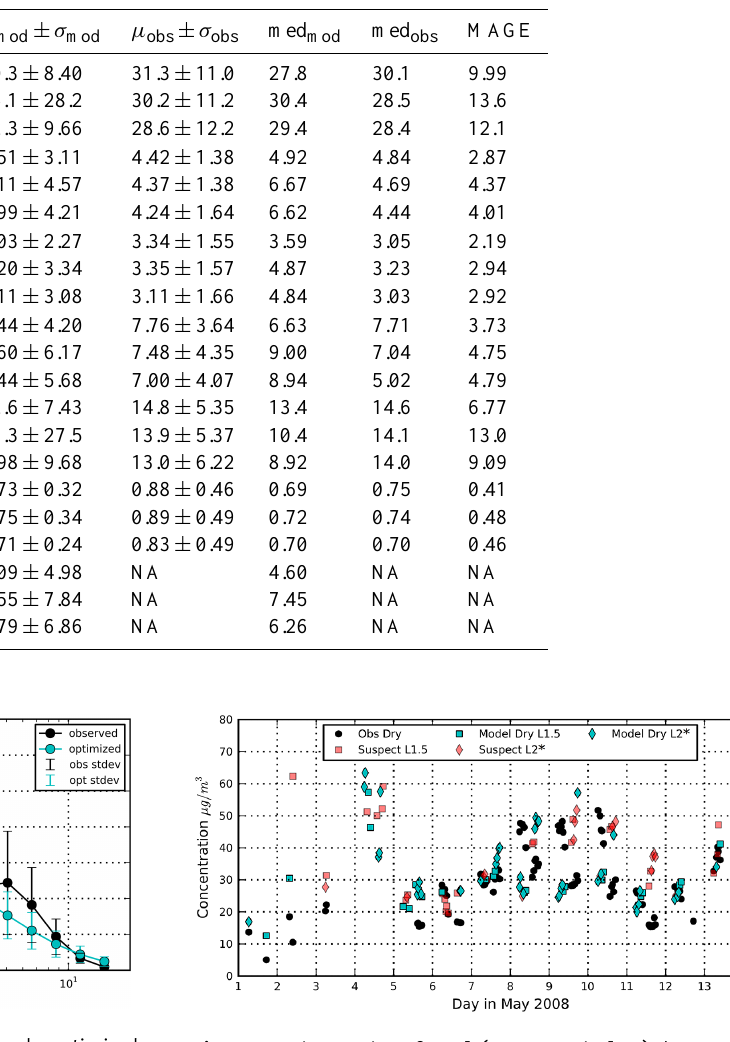
Figure 7. Time series of total (PM 10 equivalent) dry mass con- centration from surface measurements (black dots), and our model results (turquoise squares and diamonds for results based on non- suspect AERONET L1.5 data and L2 ∗ data, respectively) during the first half of May 2008 at the Cabauw Tower. Results based on AERONET data that have been labeled “suspect” are presented in